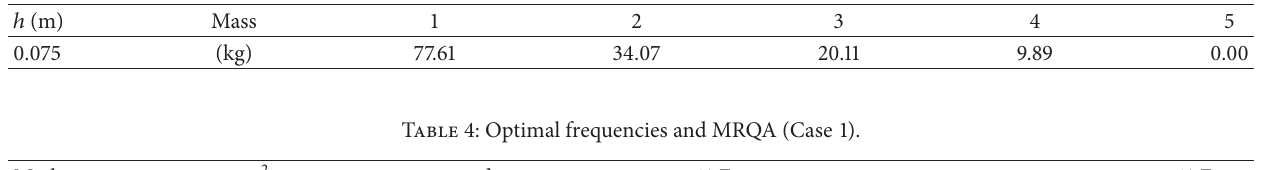
Table 3: Optimal design variables (Case 1).